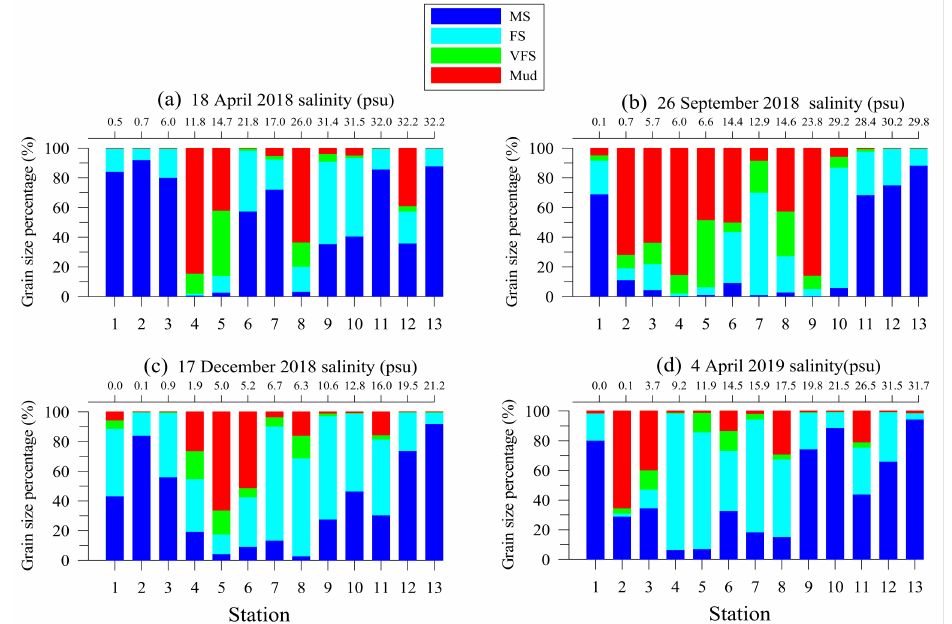
Figure 5. Percentage distributions of four sediment grain size fractions in the DRE during the different surveys. ( a ) 18 April 2018, ( b ) 26 September 2018, ( c ) 17 December 2018, and ( d ) 4 April 2019. (MS: medium sand (>177 µ m), FS: fine sand (125–177 µ m), VFS: very fine sand (63–125 µ m) and mud (<63 µ